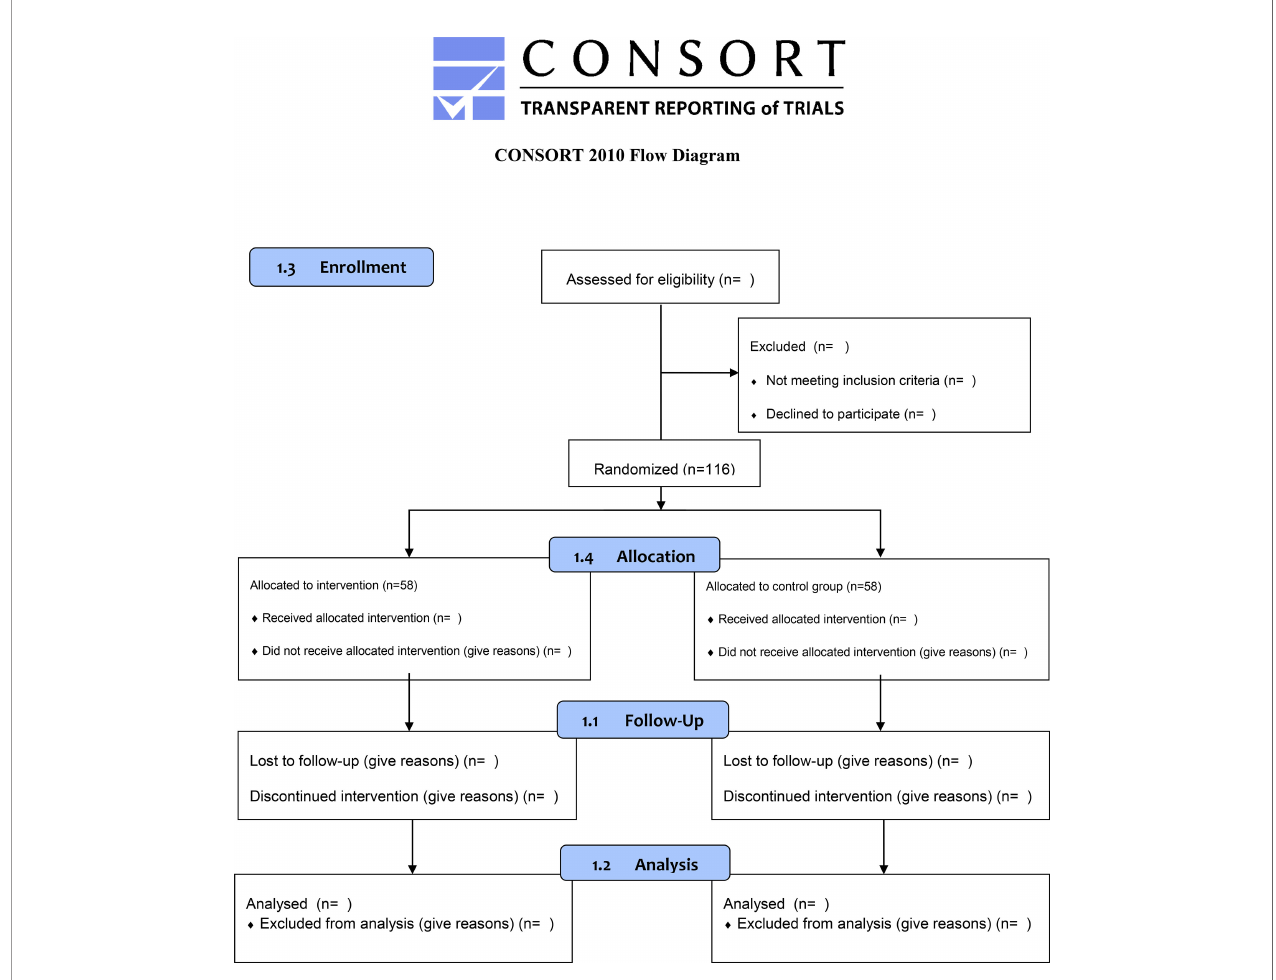
FIGURE 2 | The proposed CONSORT diagram of enrolment, allocation, follow-up, and analysis through the study for each